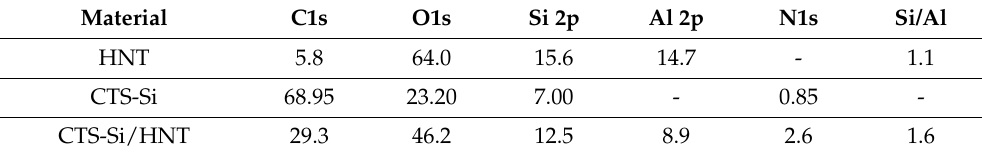
Table 3. Surface atomic percentages determined by XPS of CTS-Si/HNT., HNT., and CTS-Si.